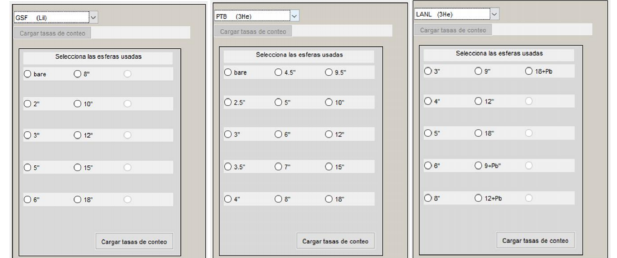
Figure 9. Drop-down selection menu for selecting different